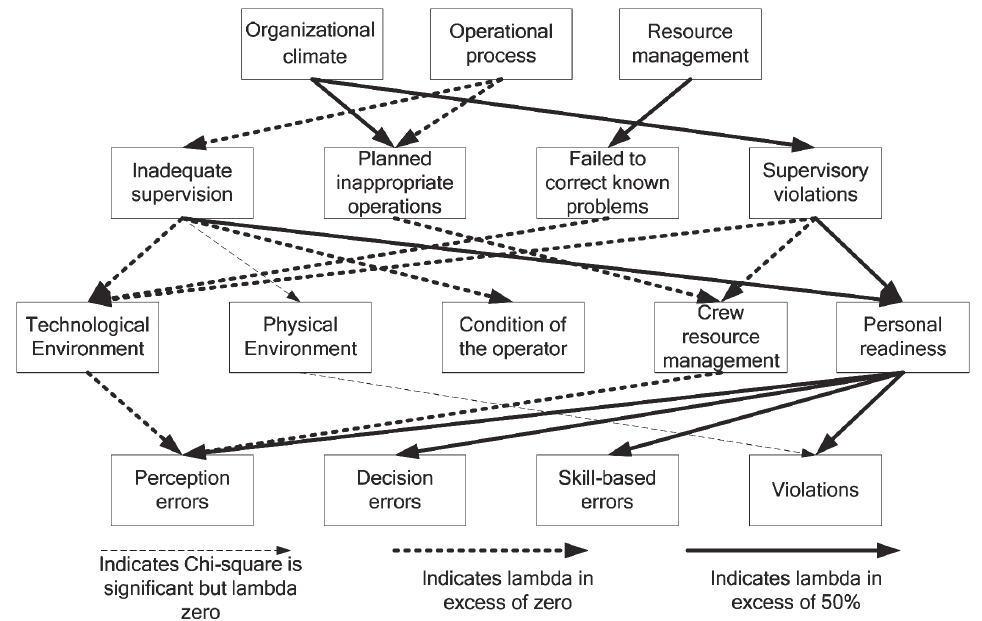
Figure 2. The simple associations graphs of fall from height accident type